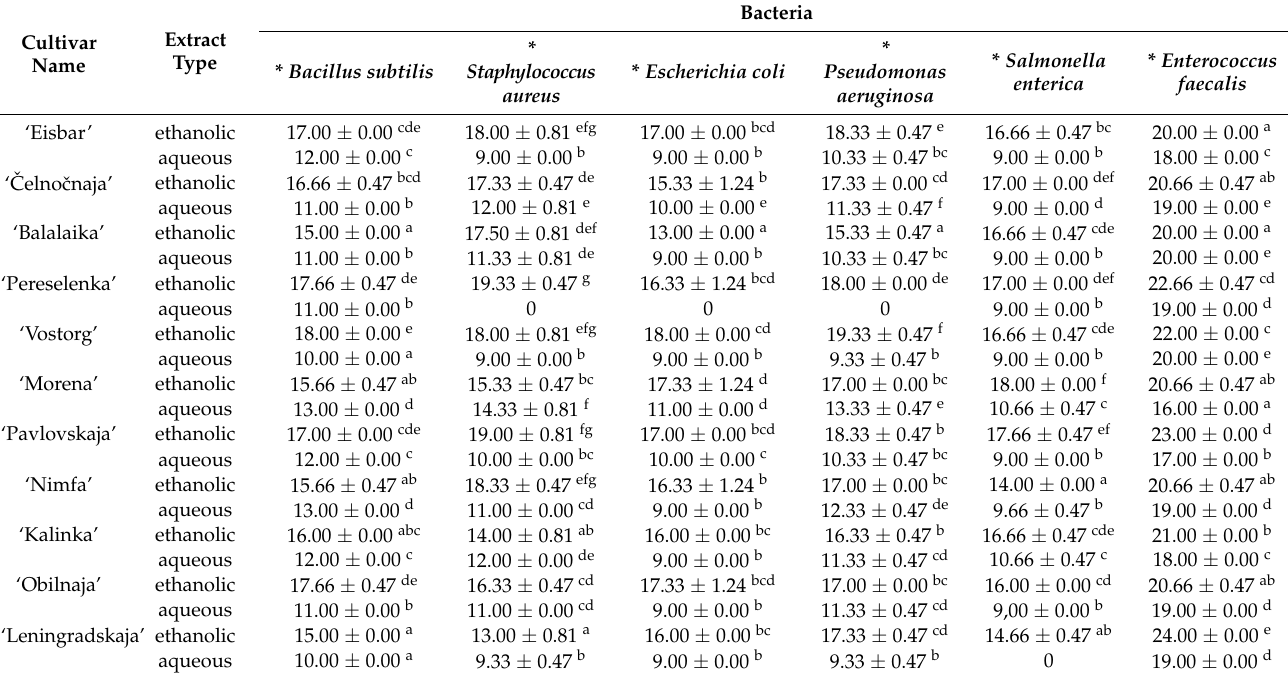
Table 6. Antibacterial activity of ethanolic and aqueous berry extracts of L. caerulea cultivars, presented as mean inhibition zone diameter ± SD in mm ( n = 3) including well diameter (8